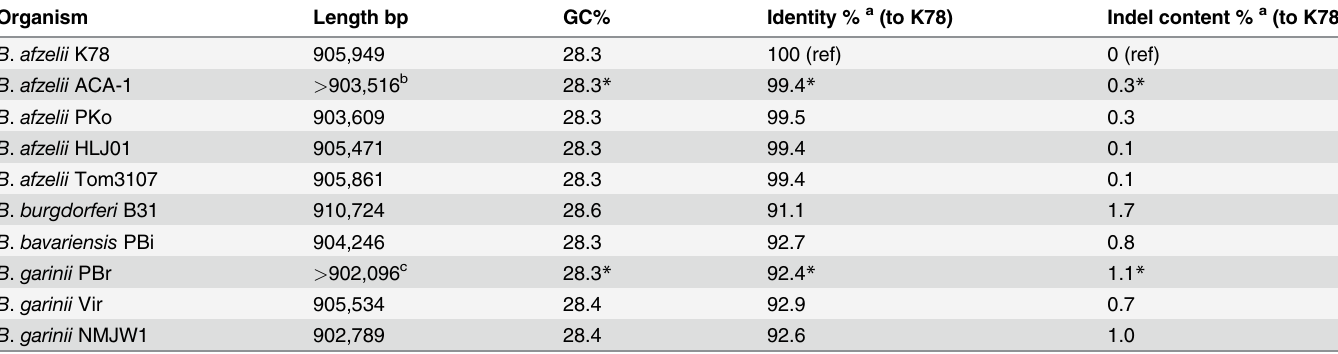
Table 3. Comparison of the K78 chromosome to representative chromosomes within Borrelia.